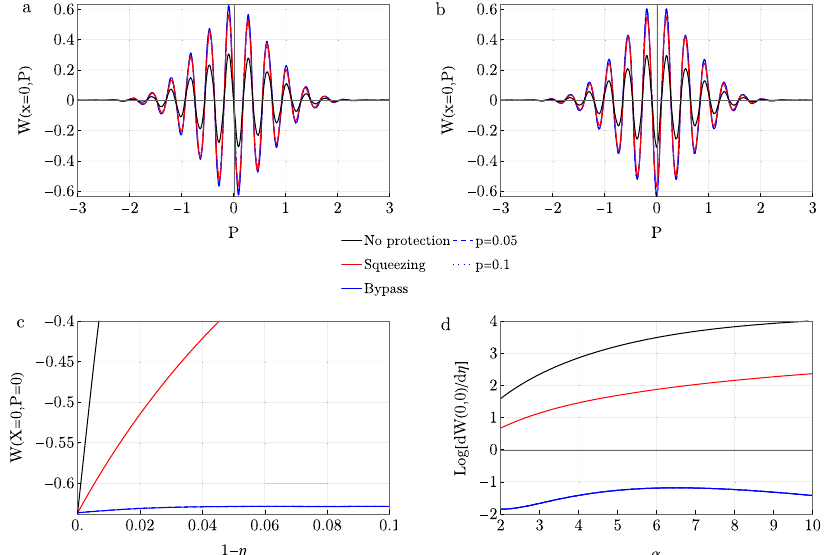
Fig. 3 Protection of negative peaks of Wigner functions of superposition of two coherent states as in Fig. 1b. a , b Interference fringes in cross-section of the Wigner function for α j i þ e i ϕ (cid:3) α j i at α = 6 with ϕ = π /2, π under 1 − η = 0.01 of loss and p = 0, 0.05, 0.1 of dephasing. The interference fringes for complete lossy channel η = 0 and under various p 's are overlapped largely with the initial curve. c The depths of the negative peak located at phase space origin vs. loss parameter 1 − η at α = 6 for the initial state α j i (cid:3) (cid:3) α j i (curves with p > 0 are overlapped), d and the logarithm of slopes of the curves in c vs. α